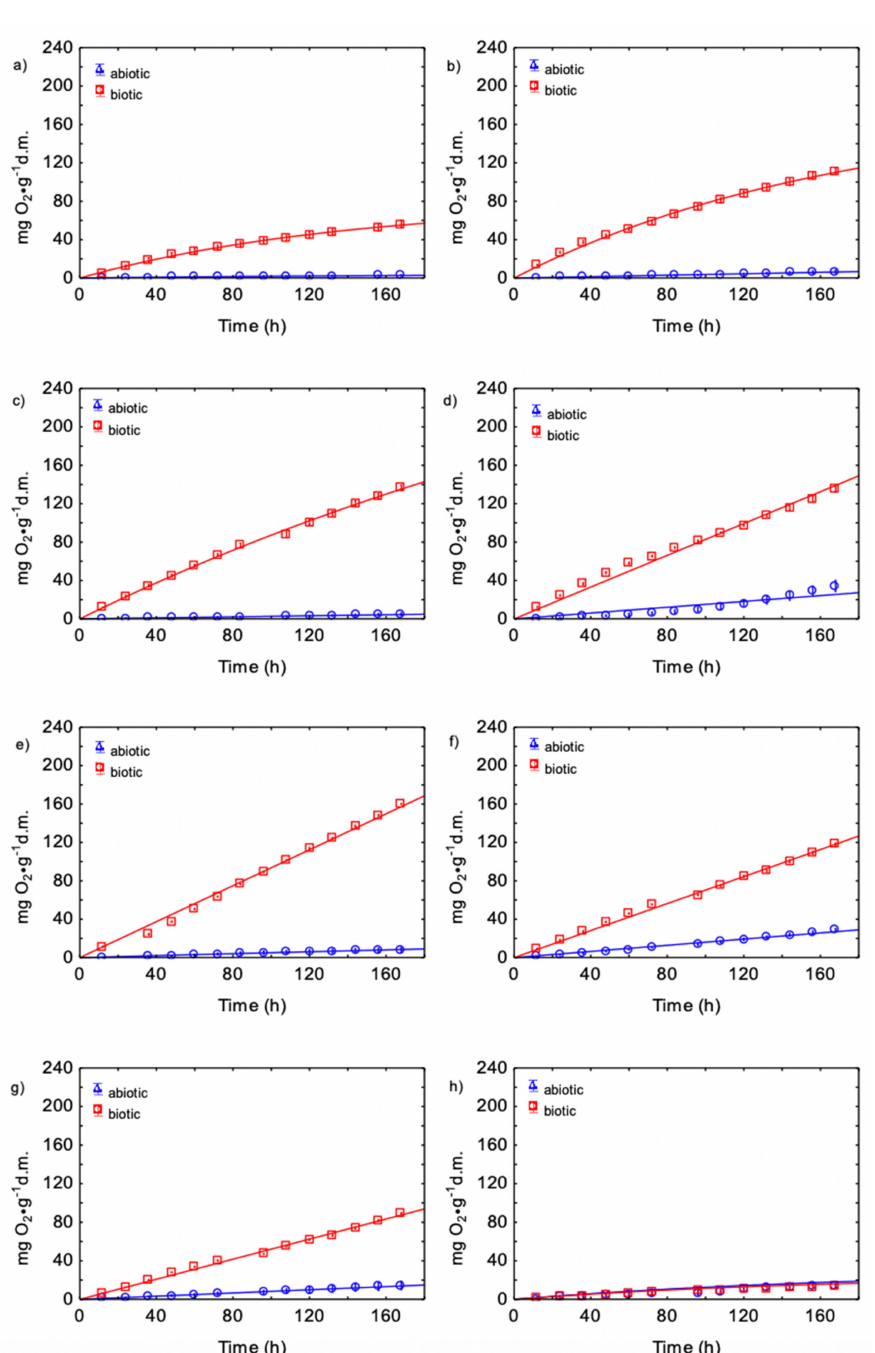
Figure 4. Cumulative O 2 consumption depending on the temperature under abiotic and biotic conditions under di ff erent fixed temperatures ( a ) 10 ◦ C, ( b ) 20 ◦ C, ( c ) 30 ◦ C, ( d ) 37 ◦ C, ( e ) 40 ◦ C, ( f ) 50 ◦ C, ( g ) 60 ◦ C, ( h ) 70 ◦ C.The error bars are showing +/ − standard deviation around the mean. Raw data are shown in Tables S1.1 and S1.2 (Supplementary Materials, sheet 1). The kinetic values are